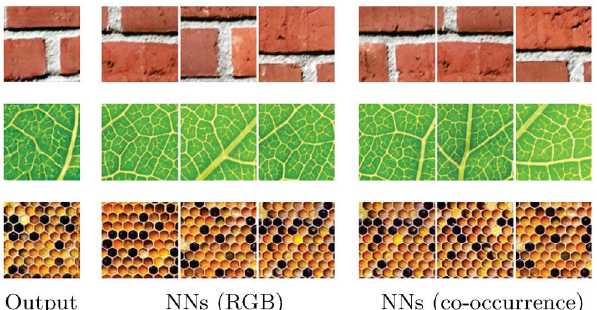
Fig. 5 Novelty of generated samples. Left: generated textures using co-occurrences from the test set. For each generated sample, we find its nearest neighbors (NNs) in the training set, measured in terms of RGB values (middle) and co-occurrences (right). As illustrated above, the generated textures are different from their nearest neighbors in the training